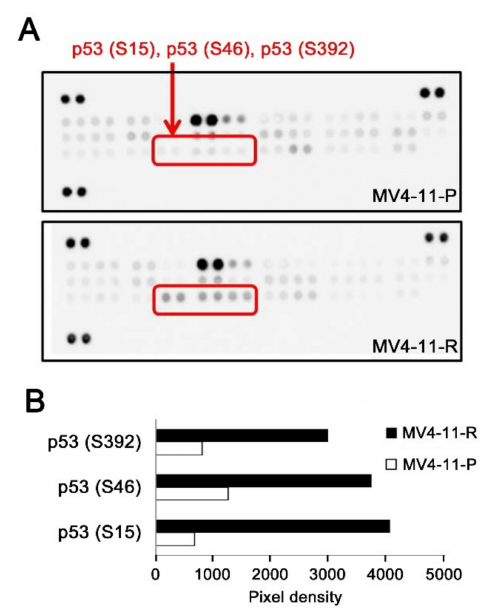
Figure 3. Apoptosis-related proteins in MV4-11-P and MV4-11-R were analyzed by human apoptosis array. ( A ) Blots of the array show increased p53 phosphorylation at serine 15, 46, and 392 in MV4-11-R compared to MV4-11-P. ( B ) Average pixel densities for duplicate spots of phosphorylated p53 were analyzed using ImageJ.